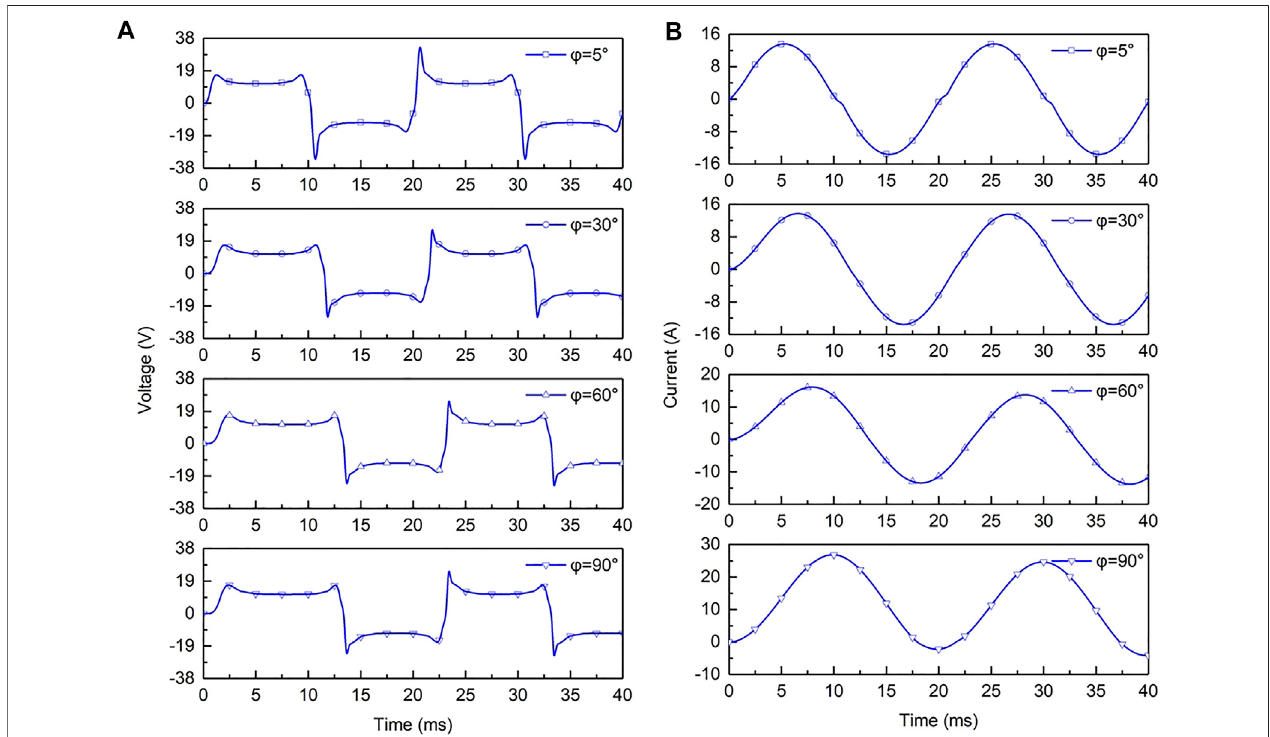
FIGURE 12 | Resistive inductive load (A) voltage and (B)